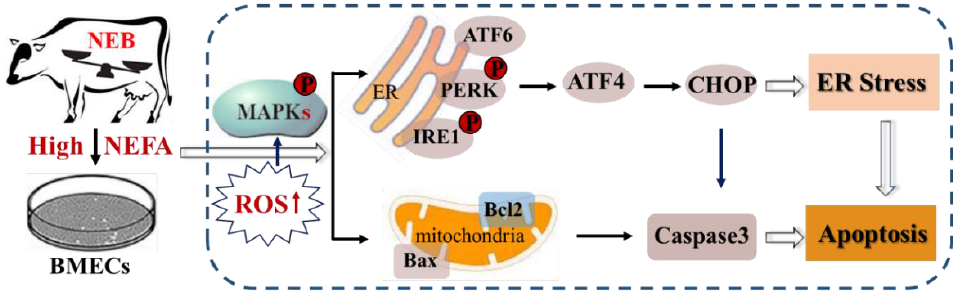
Figure 8. Signal activation pathways in BMECs treated with NEFAs. NEFA induces ROS accumu- lation, MAPKs activation, ER stress, and apoptosis in BMECs.